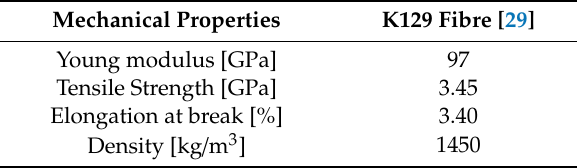
Table 1. K129 aramid composite used in this work.